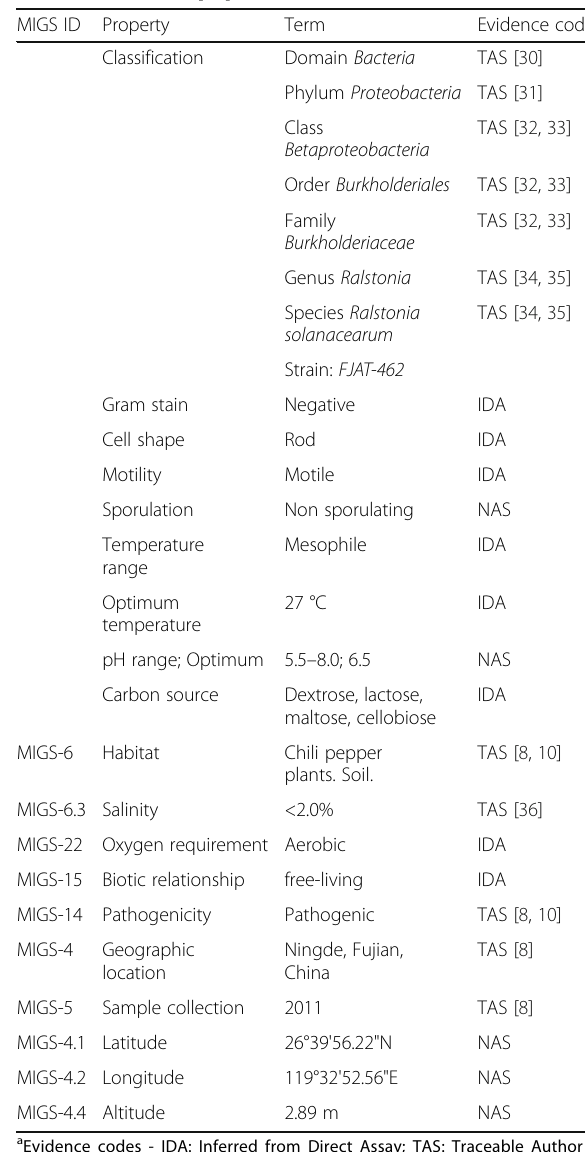
Table 3 Classification and general features of Ralstonia solanacearum FJAT-462 strain according to the